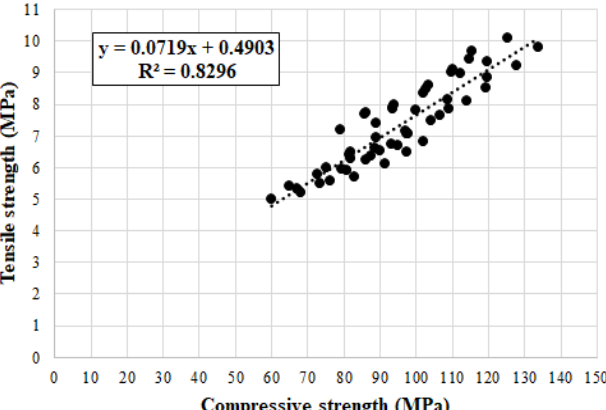
Figure 12. Compressive – tensile strength relationship of SF reinforced HSC containing NS and SP.